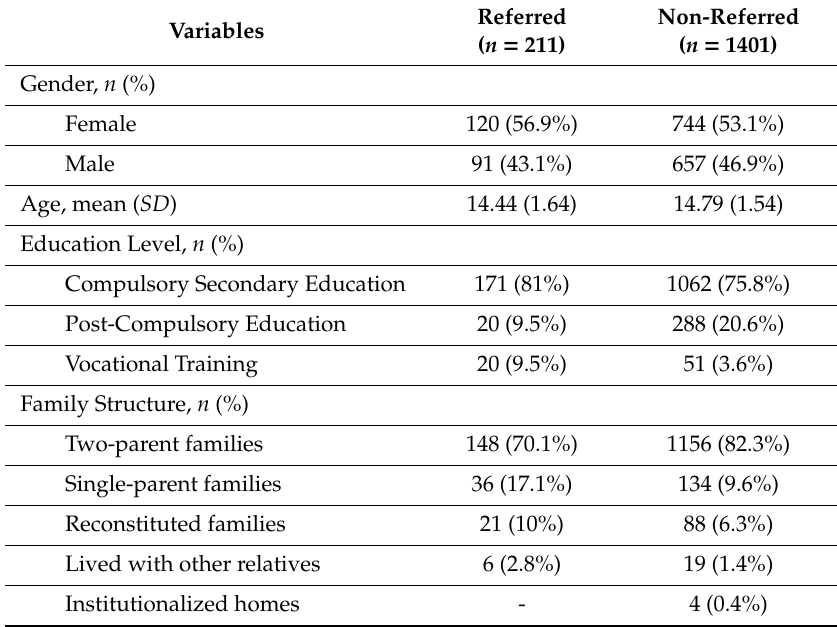
Table 1. Main demographic characteristics of the referred ( n = 211) and the non-referred sample ( n =